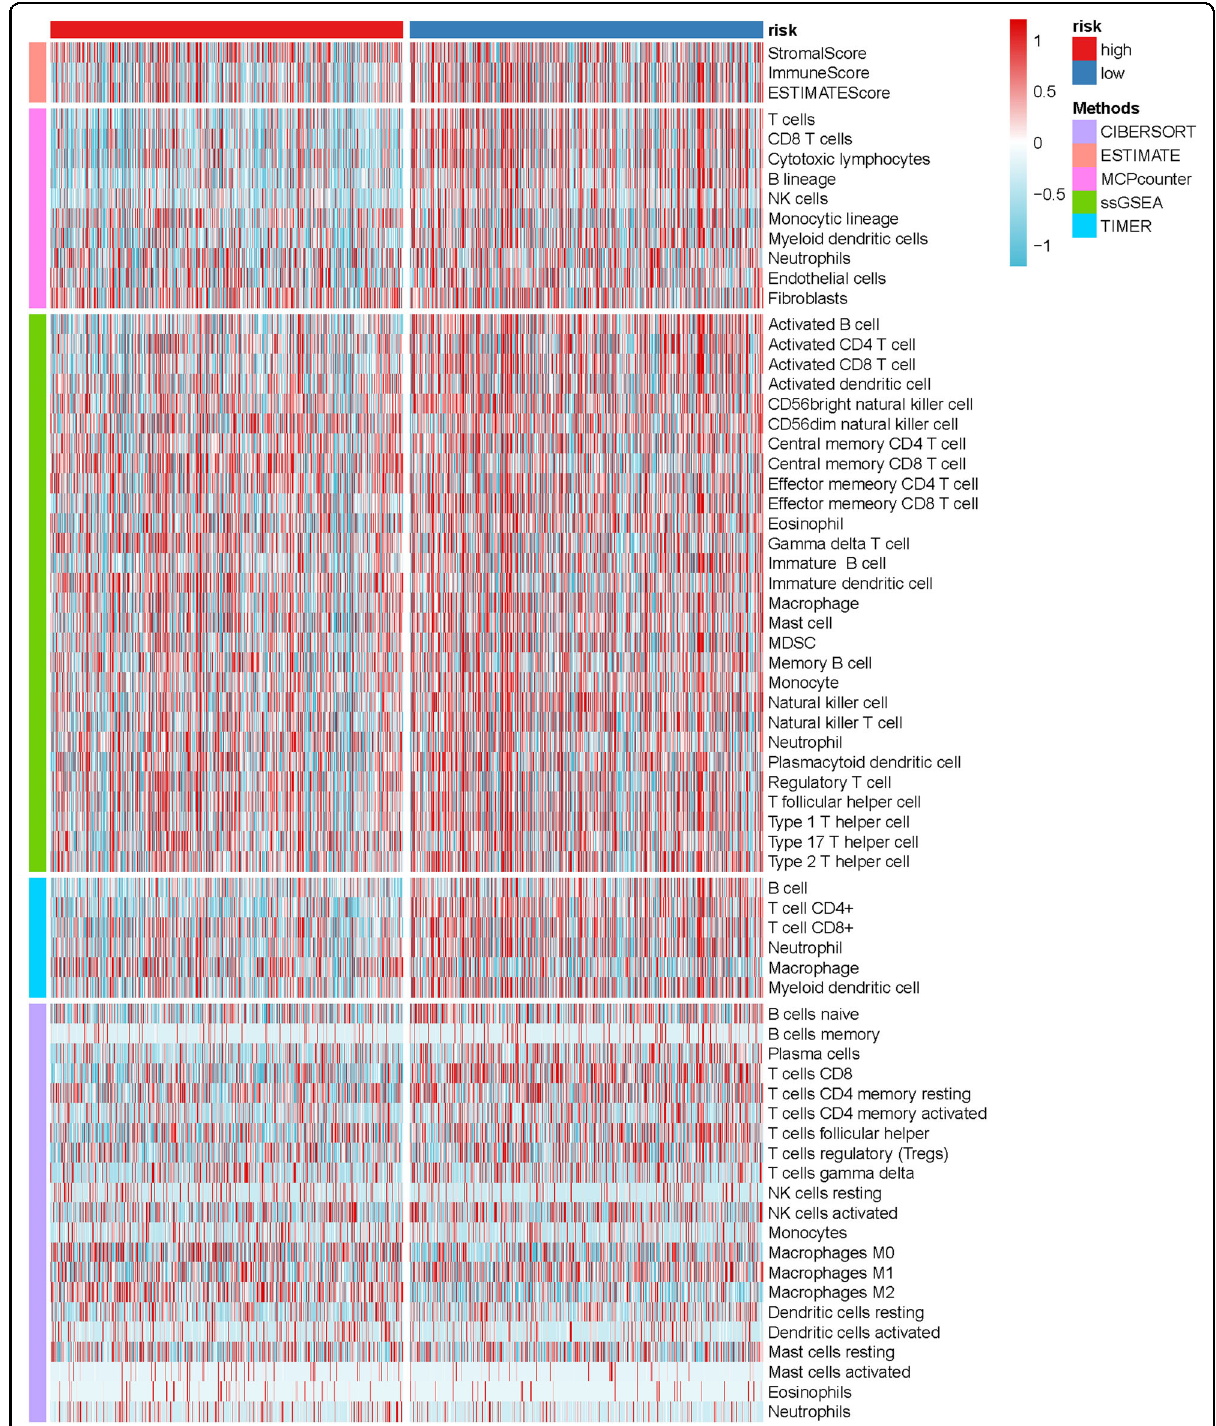
Fig. 5 The heatmap of immune responses among high risk and low risk groups based on ferroptosis-related gene signatures. The CIBERSORT, ESTIMATE, MCPcounter, ssGSEA, and TIMER algorithms to assess the cellular components or cell types of immune responses in heterogeneous samples. Red represents high expression and blue represents low